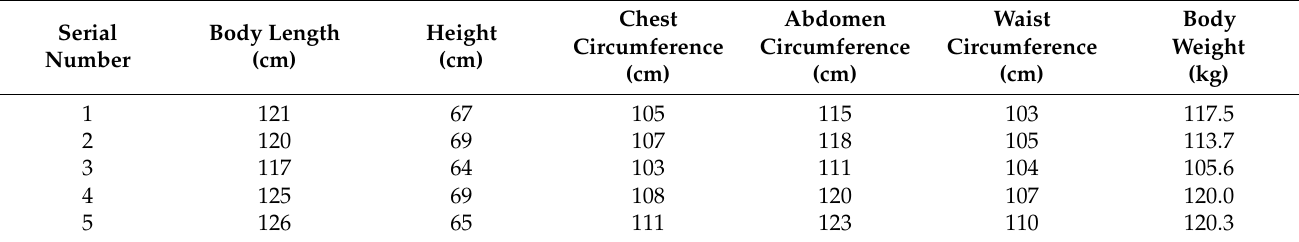
Figure 1. Five body parameters of live pigs. Table 1. Body parameter data for the five sample pigs .